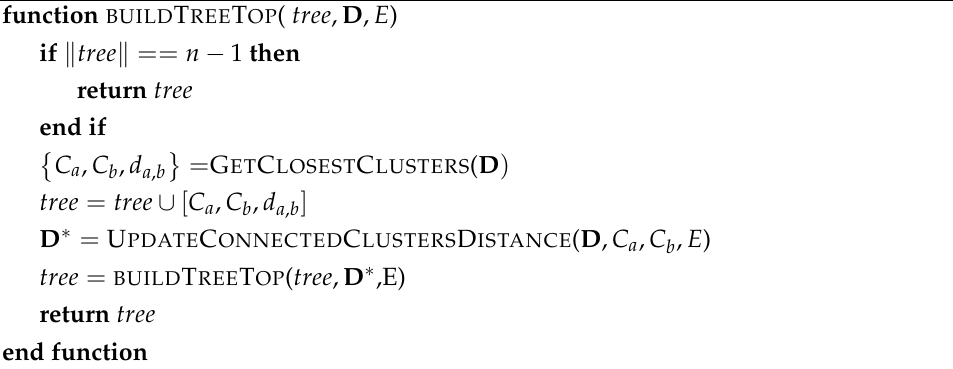
Algorithm 2 Agglomerative clustering algorithm with topology